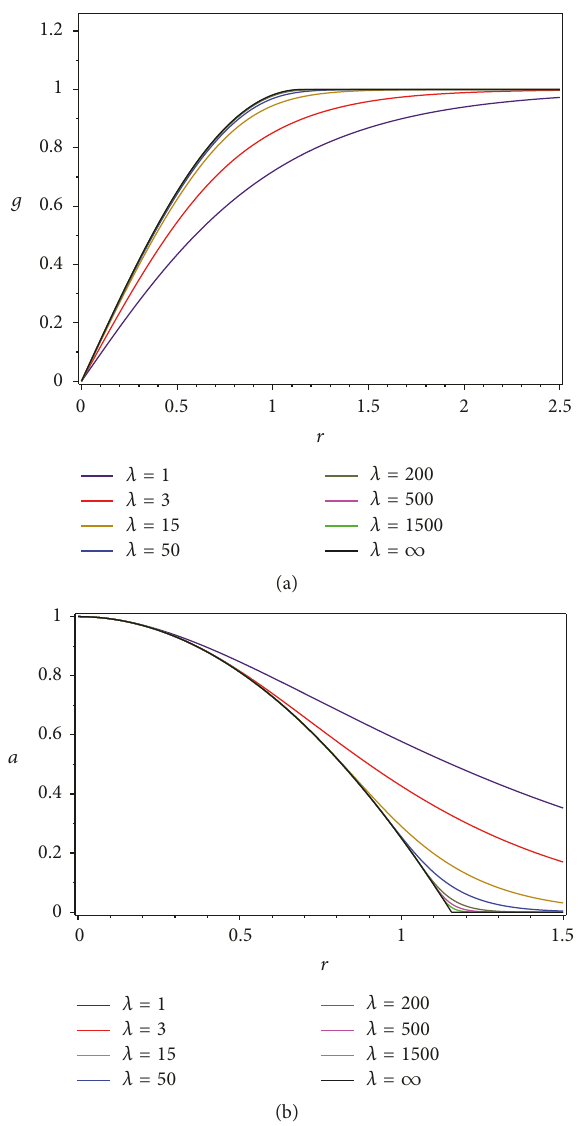
Figure 3: The profiles 𝑔(𝑟) (a) and 𝑎(𝑟) (b) come from the generalized Born-Infeld-Higgs model (43) with 𝐺(𝑔) = 1 and 𝜔(𝑔) = 𝜆𝑔 2𝜆−2 . Observe that 𝜆 = 1 (indigo lines) represents the usual BIH model and the true compacton solution is given by 𝜆 = ∞ (black